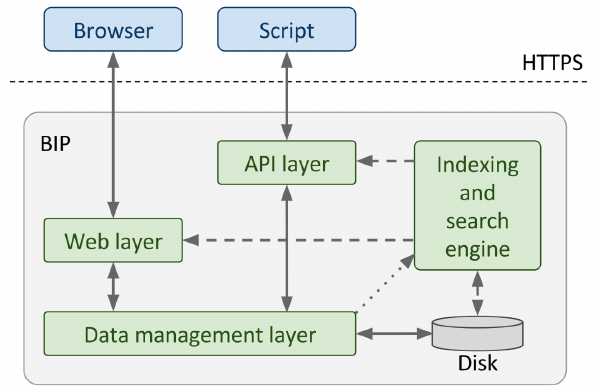
Figure 3. BIP architecture diagram. Users initiate actions with either their web browsers or API clients (blue elements). All requests go through respective access control layers (these ensure e.g. that a given set of data is accessible to the user), before they contact the data management layer to retrieve (or commit) data from (to) the database. Access mode is read/write (solid arrows). Additionally the search engine could be required to search through gathered data (dashed arrows) - it’s a read-only access mode. Finally, the data layer informs the search engine about any new data to be indexed (the dotted